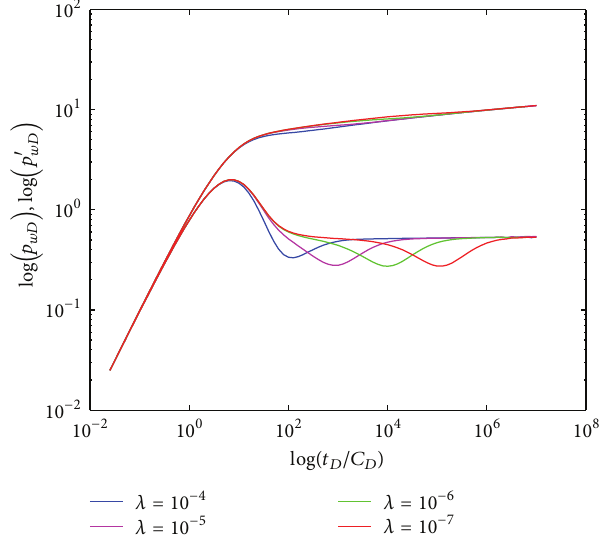
Figure 5: Effect of interporosity flow coefficient ( 𝜆 ) on type curves.